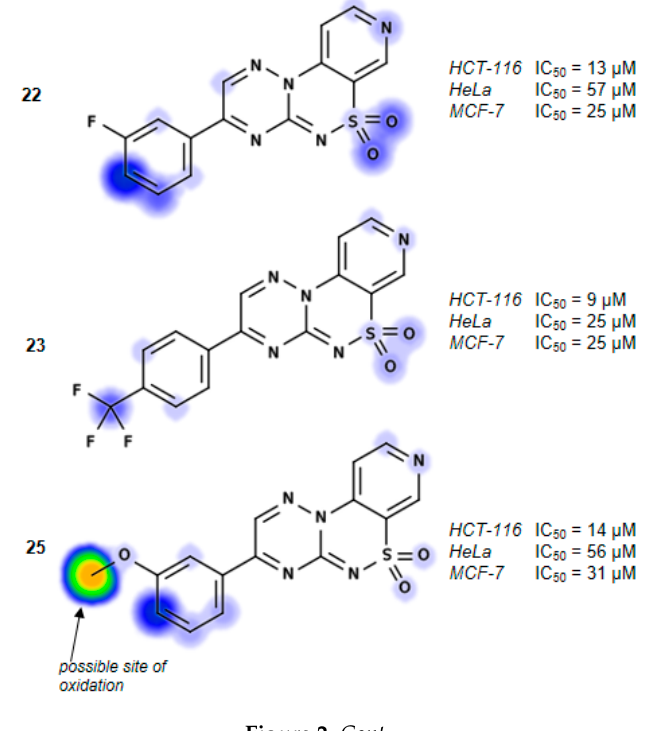
Figure 2. Cont. Figure 2.